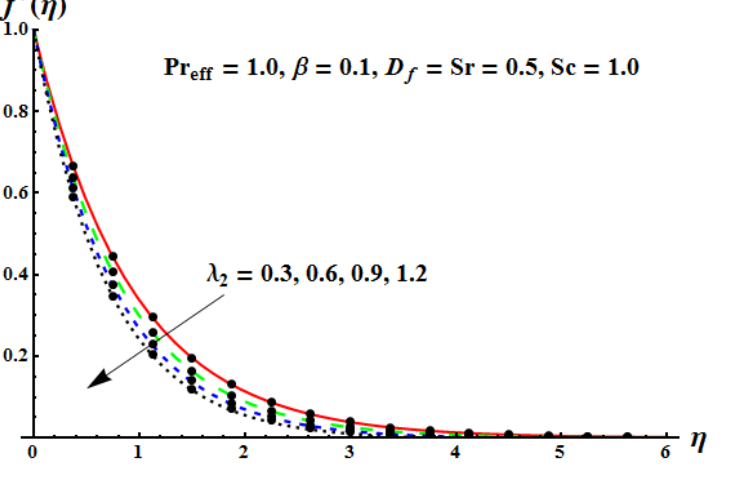
Figure 14. Influence of λ 2 on f (cid:48) ( η ) . Solid line: OHAM solution, solid circles: exact